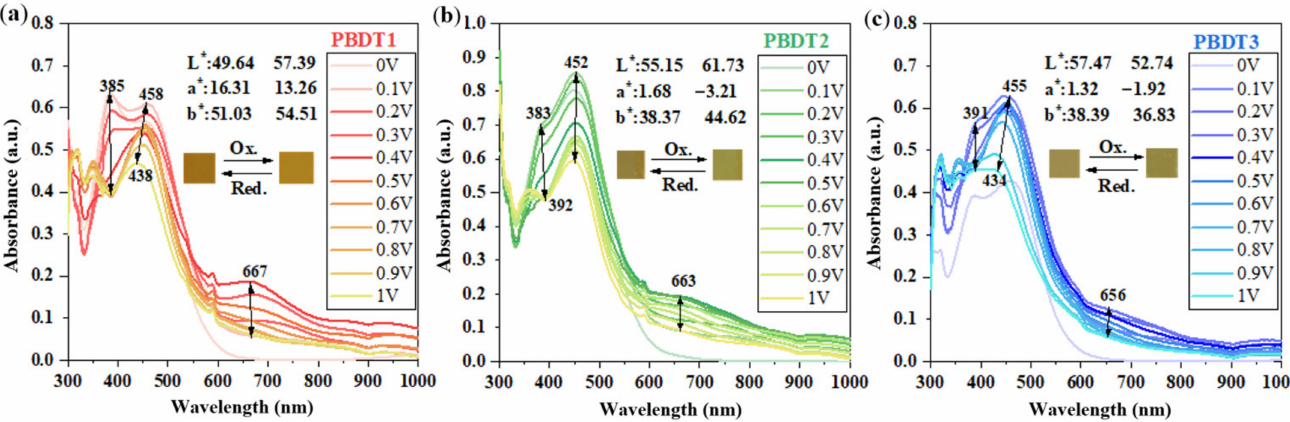
Figure 5. Spectroelectrochemical tests of ( a ) PBDT1-DTBF, ( b ) PBDT2-DTBF and ( c ) PBDT3-DTBF film processing from